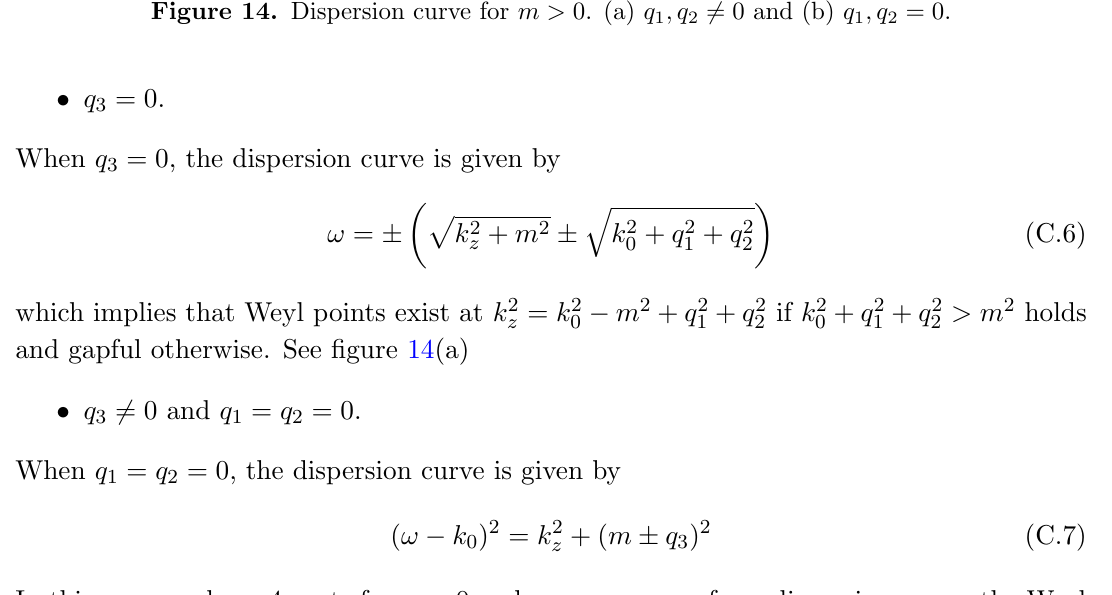
Figure 14. Dispersion curve for m > 0. (a) q 1 ; q 2 6 = 0 and (b) q 1 ; q 2 =